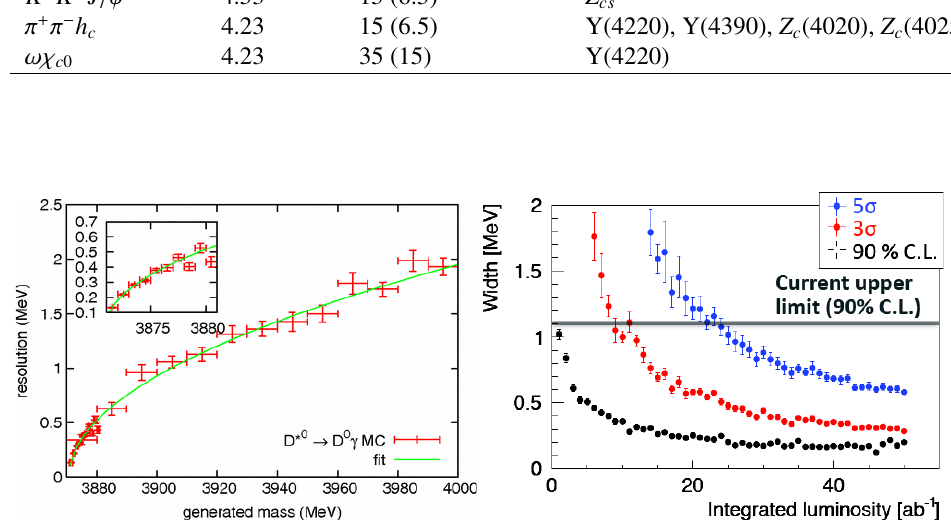
Figure 2. (Left) X(3872) mass resolutiom as a function of the X(3872) mass in the D 0 γ channel, obtained from Belle MC simulations with a X(3872) mass spectrum generated for a continuous range of masses from threshold to 4.0 GeV / c 2 . Crosses are Gaussian resolutions for various generated ¯ D ∗ 0 D 0 masses; the curve is the result of a fit with square root function. Very simlar results are obtained for the D 0 π 0 channel [30]. (Right) Width of the X(3872) as a function of the expected integrated luminosity at Belle II. The plot shows MC simulations of the estimated upper limit (black dots), evidence (red dots) and observation (blue dots) of the measured X(3872) width at Belle II. The horizontal black line is fixed to the current upper limit of 1.2 MeV for